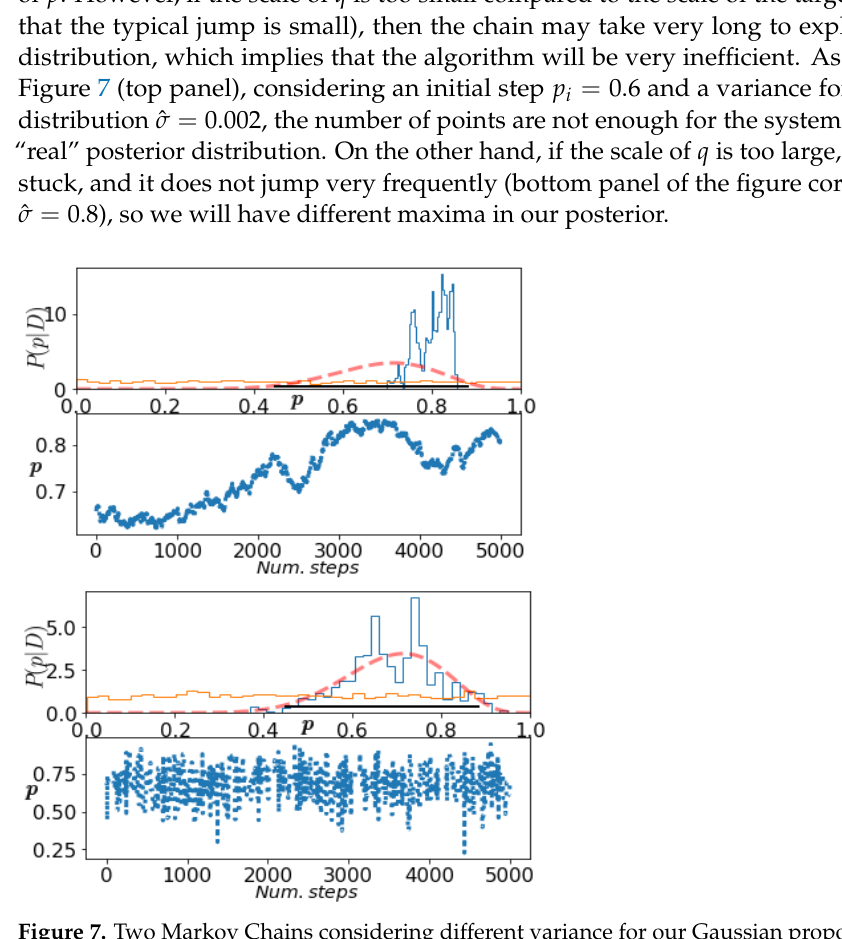
Figure 7. Two Markov Chains considering different variance for our Gaussian proposal distribution. The upper panel corresponds to ˆ σ = 0.002, while the lower panel corresponds to ˆ σ =